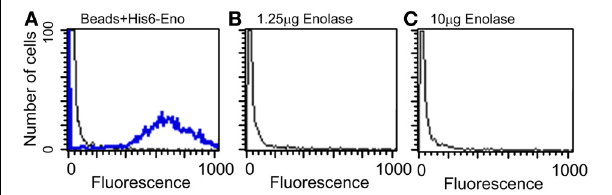
FIGURE 5 | Flow cytometry of C. albicans SC5314 incubated with purified enolase (enolase uptake assay). (A) Control beads coated with His 6 -enolase were incubated with anti-His 6 -tag (1:80) (blue line) compared with C. albicans SC5314 incubated with the elution buffer of His 6 -enolase (black line). (B) Yeasts incubated with 1.25 μ g of His 6 -enolase and subsequently incubated with anti-His 6 -tag (1:80) (no signal). (C) Yeasts incubated with 10 μ g of His 6 -enolase and incubated as (B) (no